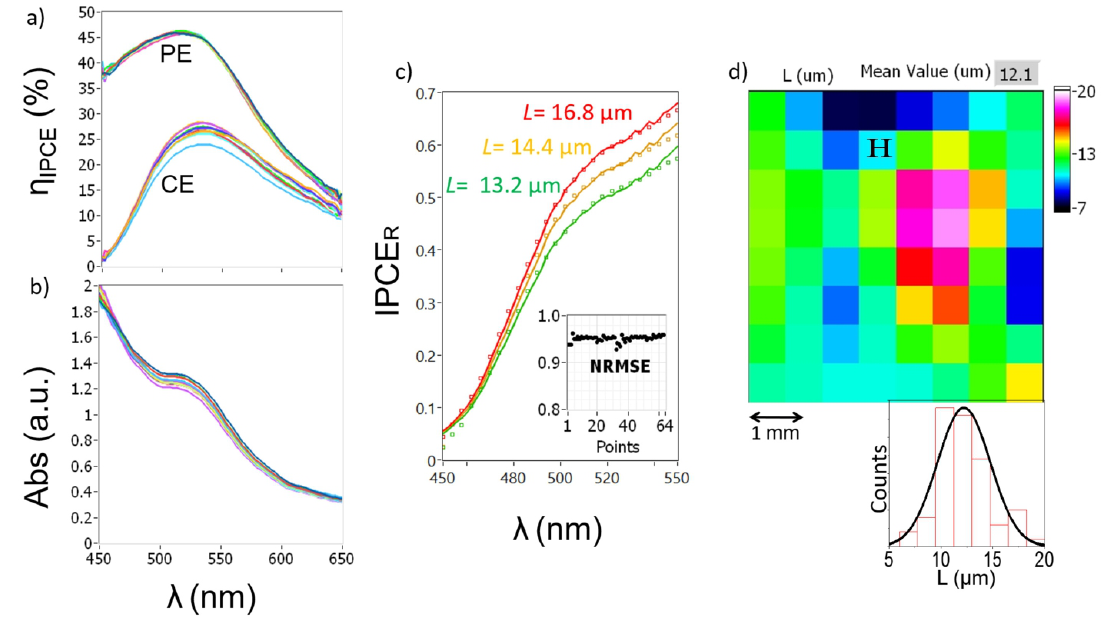
Figure 6. ( a , b ) IPCE PE and IPCE CE and absorbance spectra of 64 spatial points of the active area; ( c ) IPCE R fitting results from 450 nm and 550 nm (points are experimental values) of three spatial points. The normalized root mean square (NRMS) error for each point is plotted in the inset, showing an average value of 0.95 that confirms the goodness of fit. ( d ) Spatial map of the estimated L ; the normal distribution reported below shows an average value of 12.1 µ